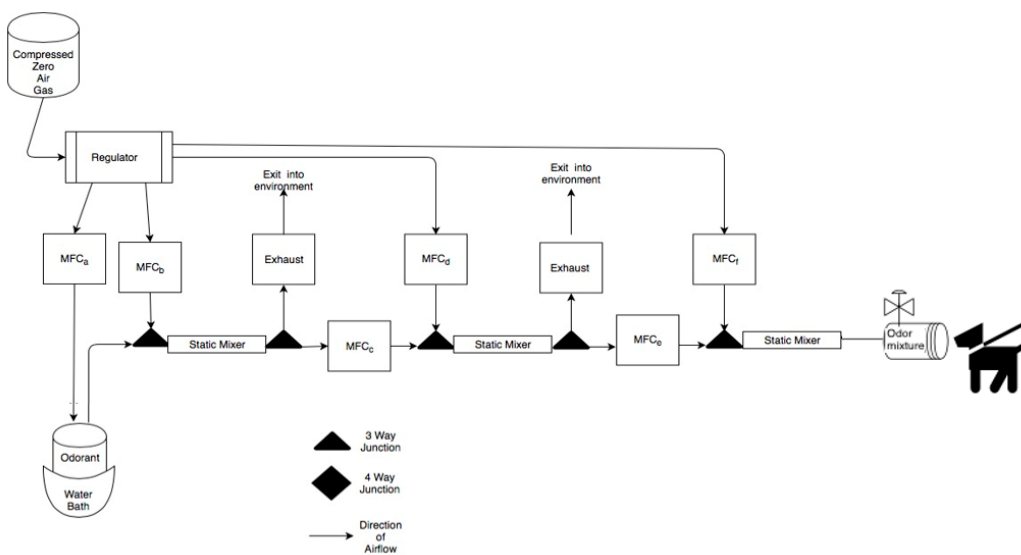
Figure 1. Schematic of the air-dilution olfactometer. Air flow path is shown from left to right and dog is shown evaluating the odor port. Briefly, compressed zero air is used to collect odorant from a sealed glass odorant jar in a water bath. The vapor stream is then systematically diluted using mass air flow controllers and turbulent static mixers. The odor line is then delivered to the odor port.